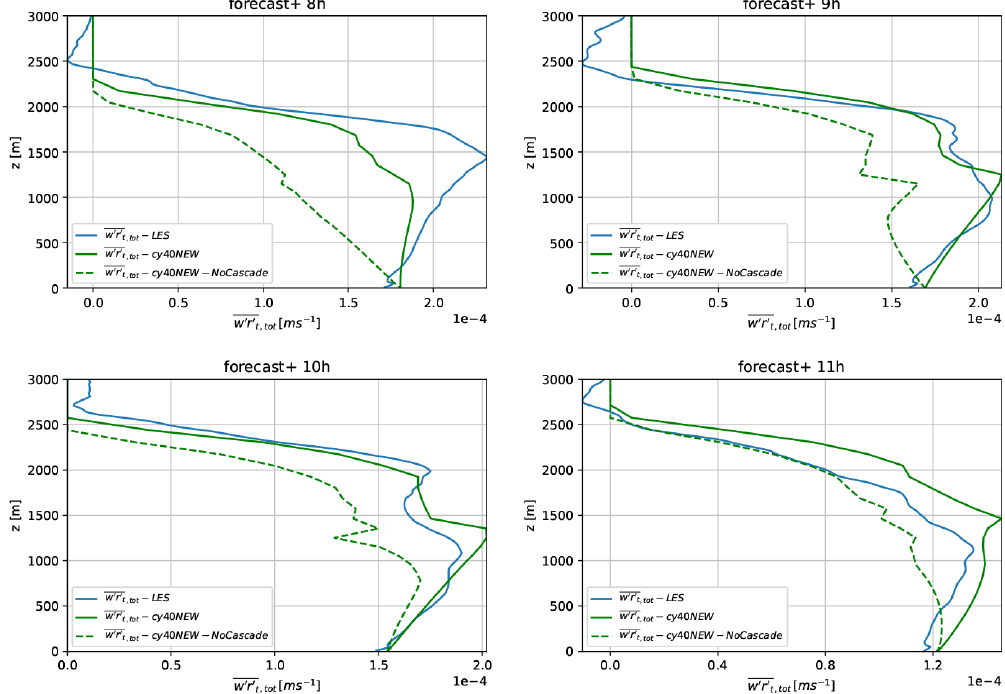
Figure 6. The kinematic total turbulent transport (ms − 1 ) during the last 4h of the ARM convective period. Plotted is the transport according to LES (blue), cy40NEW (green), and cy40NEW but without energy cascade (green dashed). Note that the x -axis scale is not constant.